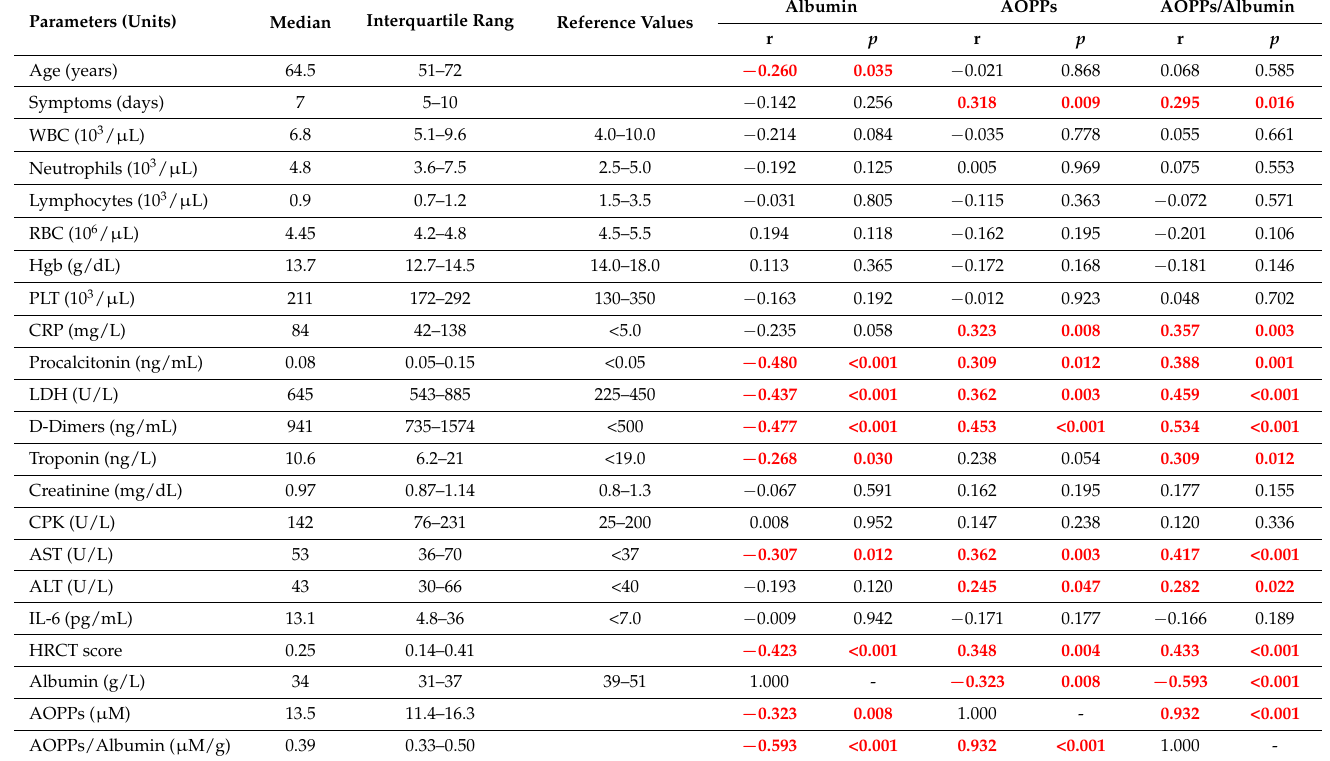
Table 1. Demographic, clinical, and laboratory parameters and their correlation with albumin, AOPPs, and the ratio of AOPPs/albumin of studied patients with COVID-19 pneumonia on admis- sion. Red-colored values indicate statistical significance ( p < 0.05). WBC, White blood cells count; RBC, Red blood cells count; Hgb, Hemoglobin; PLT, Platelets count; CRP, C-reactive protein; LDH, Lactate dehydrogenase; CPK, Creatinine phosphokinase; AST, Aspartate transaminase; ALT, Alanine transaminase; IL-6, Interleukin-6; HRCT, High-resolution computed tomography; AOPPs, Advanced oxidation protein products.